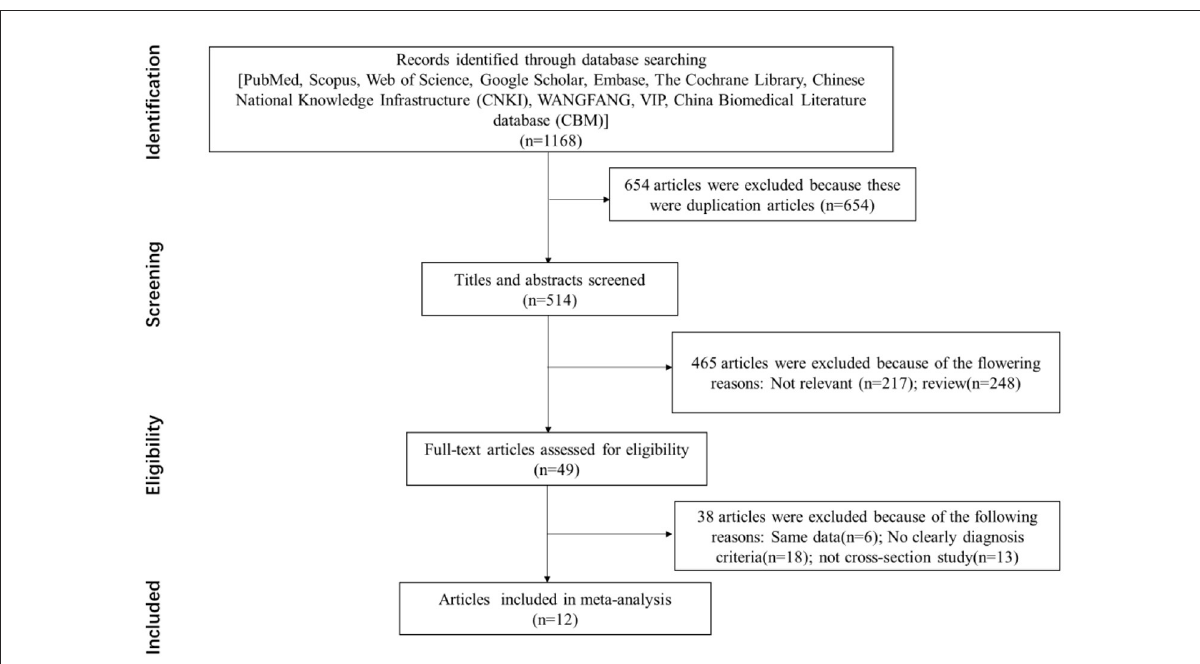
FIGURE1 Flowchart of the selection process for eligible studies [the preferred reporting items for systematic reviews and meta-analyses (PRISMA) 2009 flow